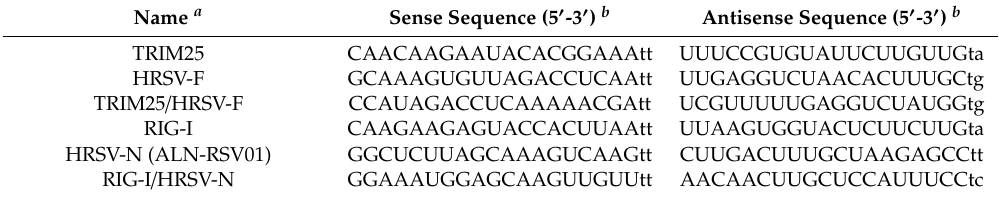
Table 1. Nucleotide sequences of the siRNAs.